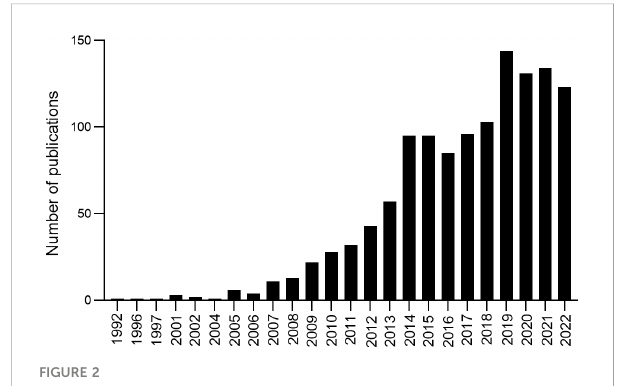
FIGURE 2 Annual number of publications and growth trends contributing to DNA/RNA methylation modi fi cation in T2DM from 1992 to 2022.